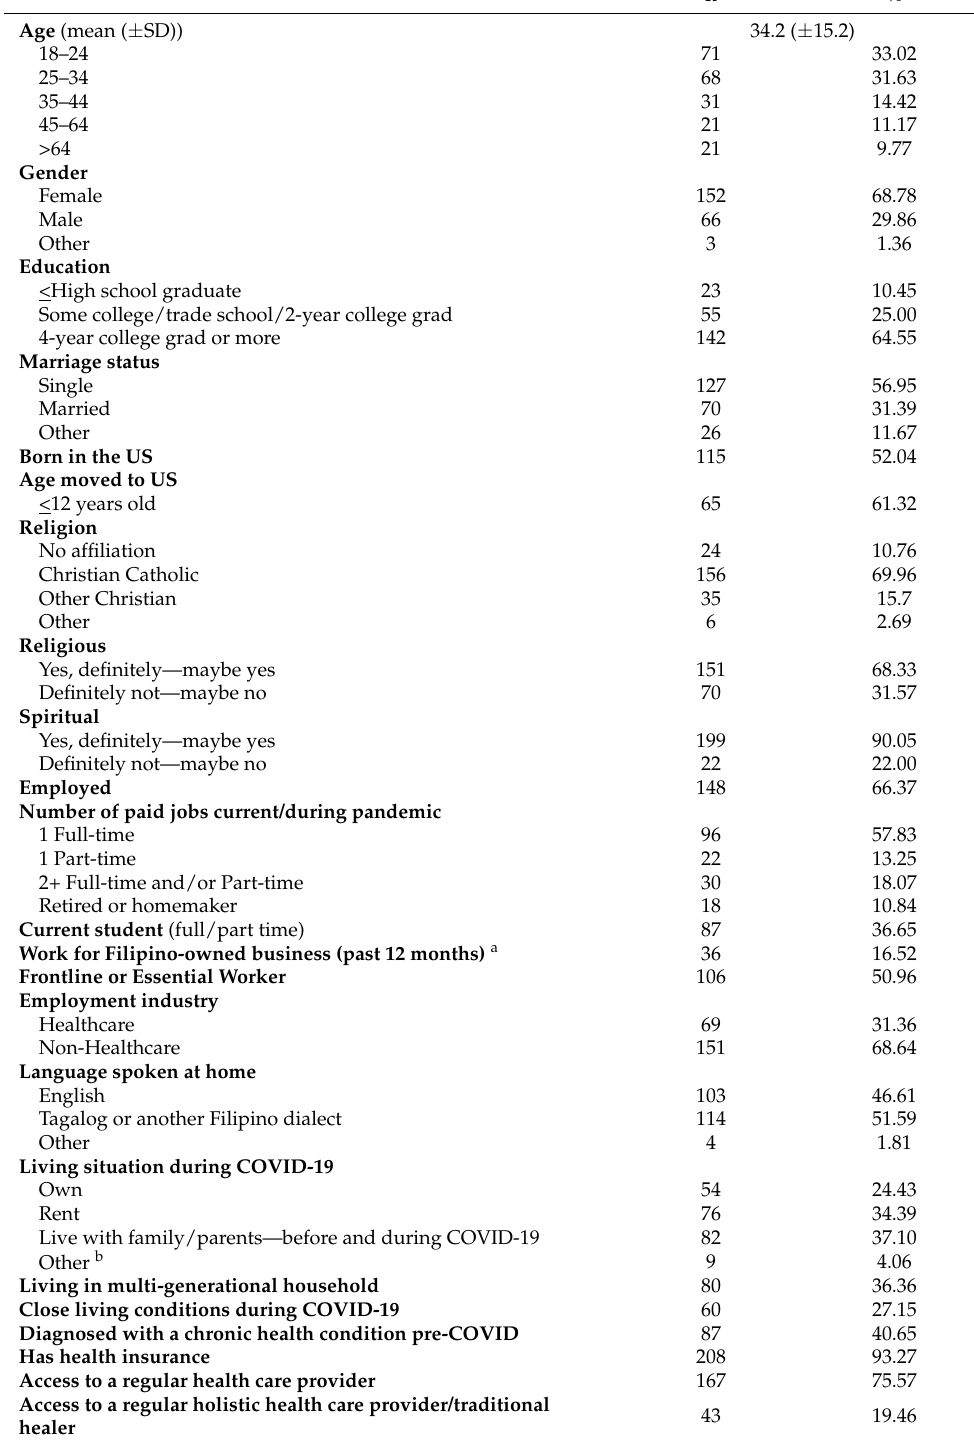
Table 1. Demographic characteristics of the Filipinx/a/o American sample (n =